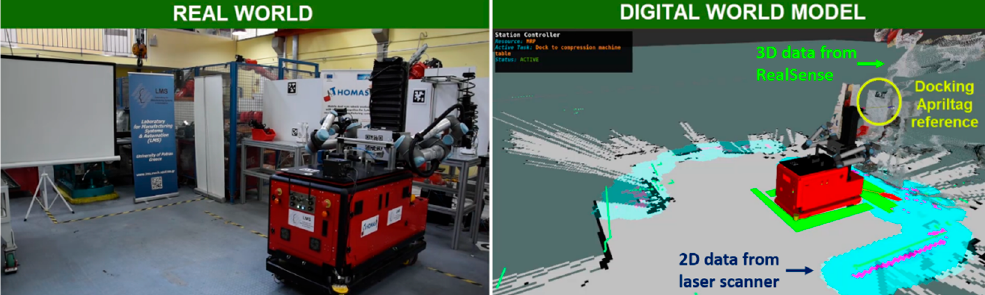
Figure 6. Virtual docking for accurate localization .